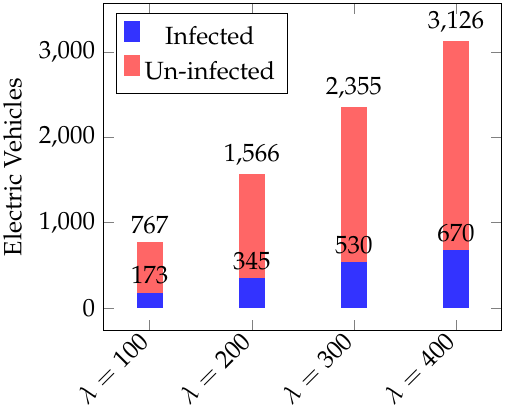
Figure 8. Infection spread through a compromised charging